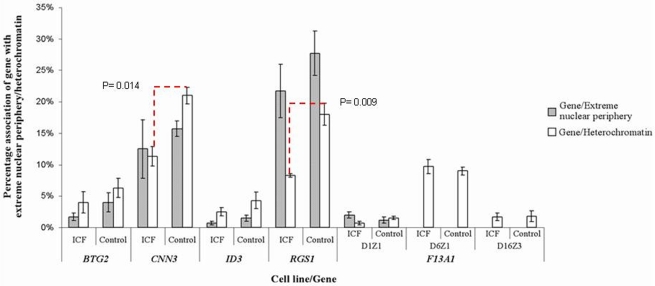

BTG2, CNN3, ID3 RGS1 and F13A1: Association with the extreme nuclear periphery and the juxtacentromeric heterochromatin.Two-colour FISH using separate probes to identify the gene and the juxtacentromeric or centromeric heterochromatin was performed on quiescent cells from ICF patient 1 and Control 1, and cycling cells from ICF Patient 1 and 2 and Control 1 and 2. Two parameters were investigated; the association of the gene with the extreme nuclear periphery and the association of the gene with heterochromatin. From left to right, the graph shows the association of BTG2, CNN3, ID3, RGS1 and F13A1 with the extreme nuclear periphery in ICF cells and controls (shaded bars), and association with chromosome 1 juxtacentromeric heterochromatin (D1Z1) in ICF and controls (white bars). The association of F13A1 with chromosome 6 centromeric heterochromatin (D6Z1) and chromosome 16 juxtacentromeric heterochromatin (D16Z3) in ICF cells and controls is also shown in the right-most four columns of the graph. A minimum of 250 observations were carried out for each experiment. The extent of co-localisation for CNN3 and RGS1 with the chromosome 1 juxtacentromeric heterochromatin was found to be significantly different when comparing ICF and control cells (χ2 = 6.028, P = 0.014 for CNN3 and χ2 = 6.775, P = 0.009 for RGS1).